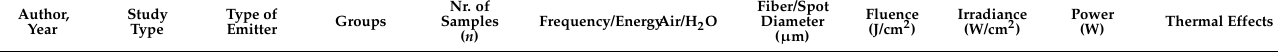
Themeanthermal effectwas35.16 ± 15.93 µ m. Themeanthermal effectwas20.44 ± 5.43 µ m. Themeanthermal effectwas29.02 ± 13.56 µ m. Themeanthermal effectwas20.30 ± 6.73 µ m.